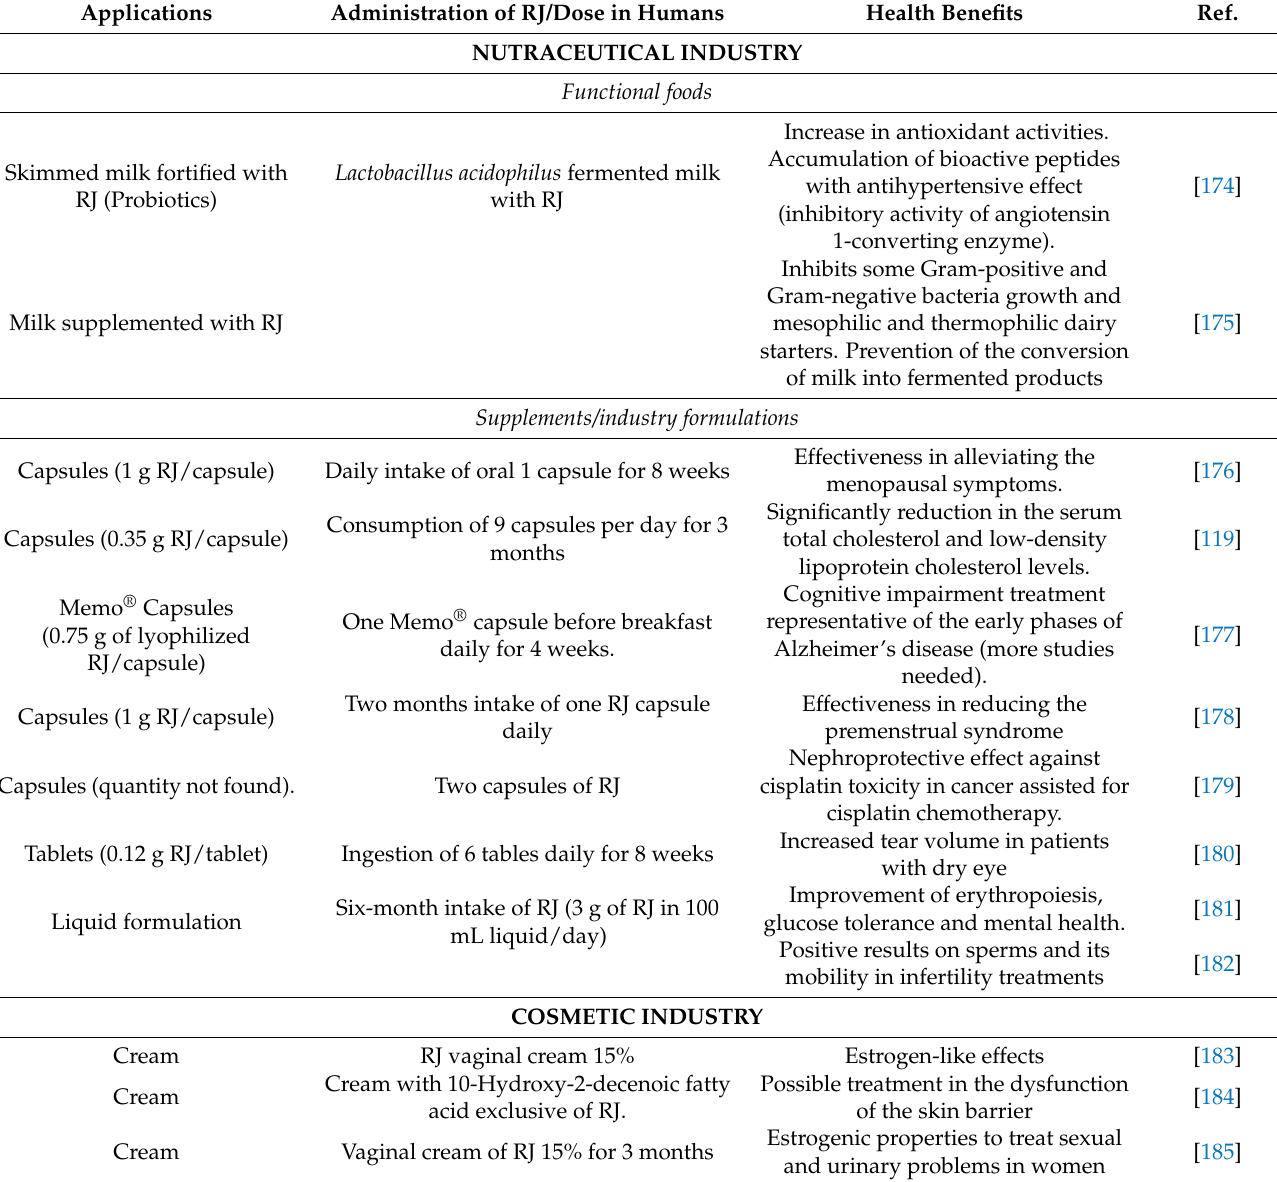
Table 3. Royal Jelly industry applications and their benefits to promote human